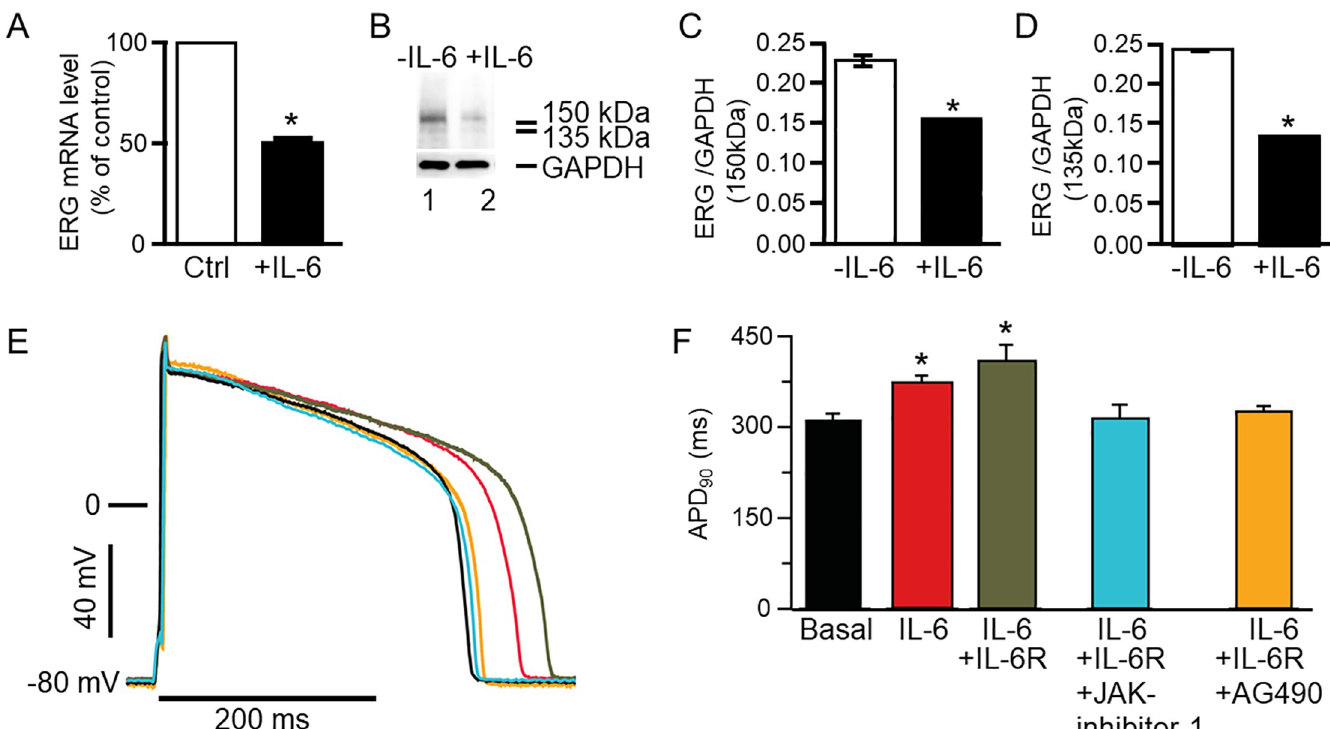
Fig 8. Effect of IL-6 on guinea pig ERG expression and action potential in ventricular myocytes. A , qRT-PCR was used to determine guinea pig ether-a´-go-go-related gene (ERG) mRNA expression in control ventricular myocytes and in myocytes pre-treated with IL-6 (20 ng/ml). B , Western blot assay of guinea pig ERG protein expression in control ( Lane 1 ) and IL-6 pretreated (for 40 mins) myocytes ( Lane 2 ). Values were normalized to the GAPDH signal and expressed as % of control or in the absence of IL-6. Each sample was analyzed in triplicate. 150 kDa and 135 kDa ERG bands were identified in lane 1 but were significantly less dense in lane 2 loaded with IL-6 (20 ng/ml) pretreated ventricular myocytes’ lysate. C , Comparison of the relative abundance of the 150 kDa ERG band in untreated and IL-6 treated myocytes. D , Comparison of the relative abundance of the 135 kDa ERG band in untreated and IL-treated myocytes. The 37 kDa bands represent GAPDH. E , Action potential waveforms recorded in control myocytes (basal conditions without IL-6, Black trace ) and in the presence of IL-6 alone ( Red trace ), IL-6+IL-6R ( Grey trace ), IL-6+IL-6R +JAK inhibitor-1 ( Cyan trace ) and another JAK inhibitor AG490 ( Orange trace ). F , Pretreatment of myocytes with IL-6 and IL-6+IL-6R significantly prolonged APD 90 and JAK inhibitor I and AG490 completely reversed the prolongation of the action potential.